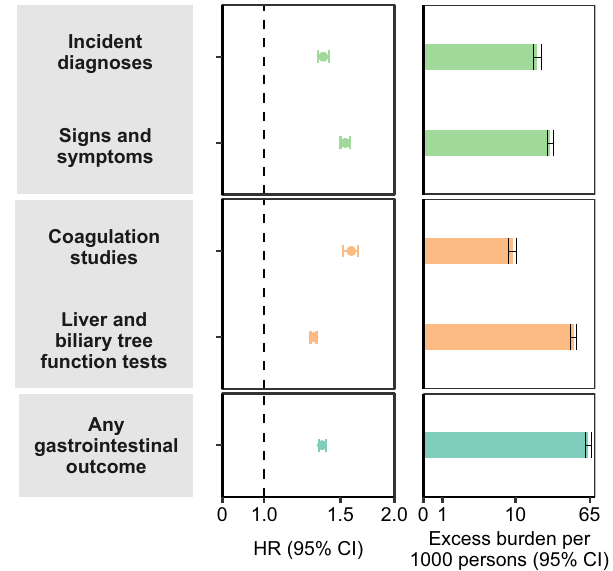
Fig. 2 | Risks and 1-year burdens of incident post-acute COVID-19 composite gastrointestinal outcomes compared with the contemporary control cohort. Composite outcomes consisted of incident diagnoses (GERD, PUD, acute pan- creatitis, functional dyspepsia, acute gastritis, IBS, and cholangitis), signs and symptoms (constipation, abdominal pain, diarrhea, vomiting, and bloating), coa- gulation studies (PT, PTT, INR), liver and biliary tree function tests (albumin, ALT, total protein, AST, LDH, CRP, ALP, total bilirubin, GGT, direct bilirubin, lipase, and amylase) and any gastrointestinal outcome (incident occurrence of any gastro- intestinal outcome studied). Outcomes were ascertained 30d after the COVID-19- positive test until the end of follow-up. COVID-19 cohort ( n = 154,068) and con- temporary control cohort ( n = 5,638,795). Adjusted HRs (dots) and 95% (error bars) CIs are presented, as are estimated excess burdens (bars) and 95% CIs (error bars). Burdens are presented per 1000 persons at 12 months of follow up. The dashedlinemarksaHRof1.00;lowerlimitsof95%CIswithvaluesgreaterthan1.00 indicate signi fi cantly increased risk. GERD gastroesophageal re fl ux disorder, IBS irritable bowel syndrome, PT prothrombin time, PTT partial thromboplastin time, INR international normalized ratio, ALT alanine transaminase, AST aspartate transaminase, LDH lactate dehydrogenase, CRP c-reactive peptide, ALP alkaline phosphatase, GGT γ -glutamyl